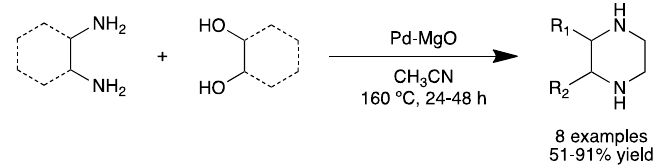
Figure 4. Tandem oxidation/condensation/reduction over PdNPs/Fe 2 O 3 ( a ) [43] and PdNPs/TiO 2 ( b ) [44]. Different types of atoms in a fcc nanoparticle ( c ). Reproduced from [56] with permission from the American Chemical